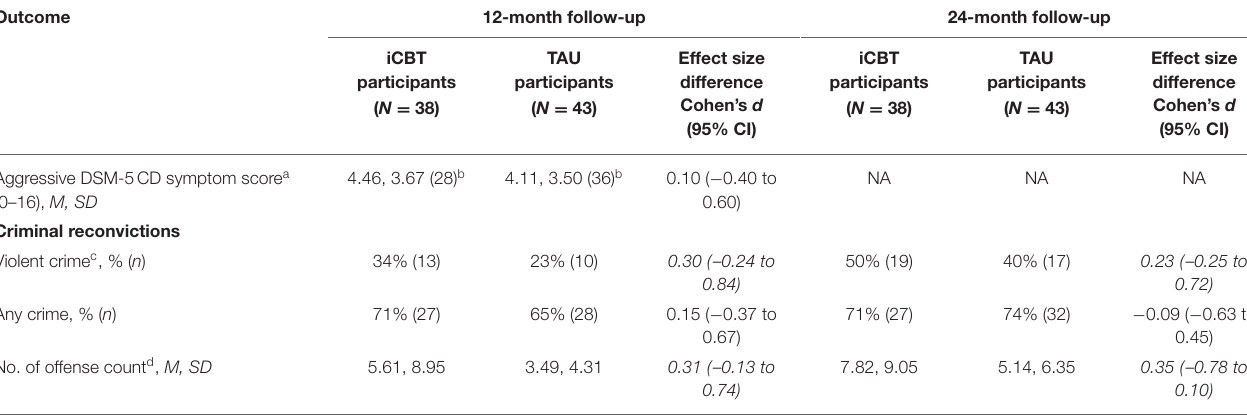
TABLE 3 | Aggressive symptoms and register-based criminal reconvictions at follow-up in an RCT of an individualized CBT intervention (iCBT) plus treatment-as-usual (TAU) vs. TAU-only among convicted serious, young male violent offenders. Outcome 12-month